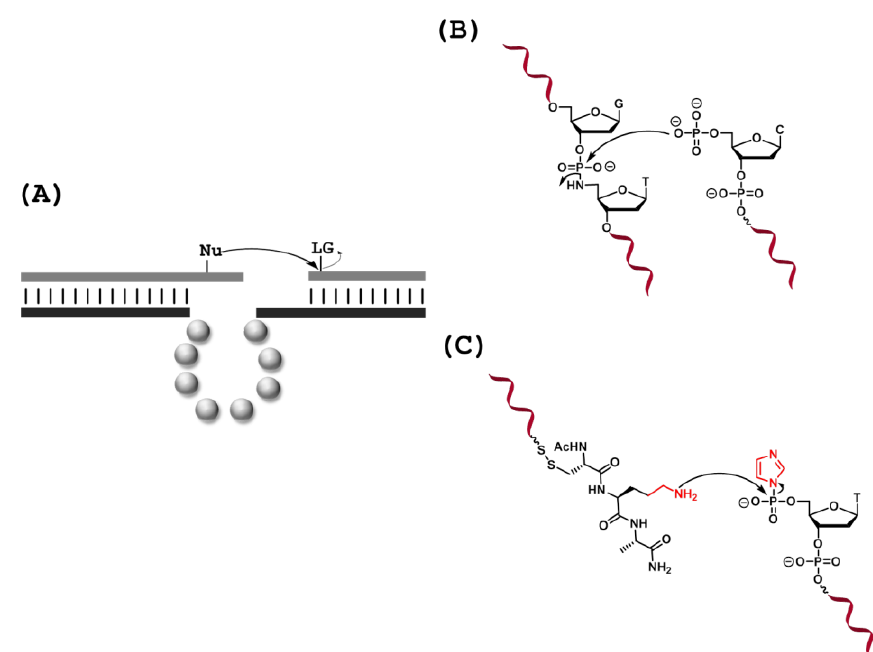
Figure 8. ( A ) General representation of DNAzyme catalyzed ligation reactions. A nucleophile (e.g., an RNA 2′-OH, a terminal 3′-OH, hydroxyl groups of serine and tyrosine, or an amine) located on a substrate attacks an electrophilic position (e.g., 5′-triphosphate, 5′-phosphorimidazolide) located on the second substrate with the concomitant eviction of a leaving group; ( B ) Catalyzed ligation reaction by hydrolysis of a phosphoramidate bond [162]; ( C ) DNAzyme catalyzed nucleophilic attack of an amine group of a lysine residue on a 5′-phosphorimidazolide unit [172].